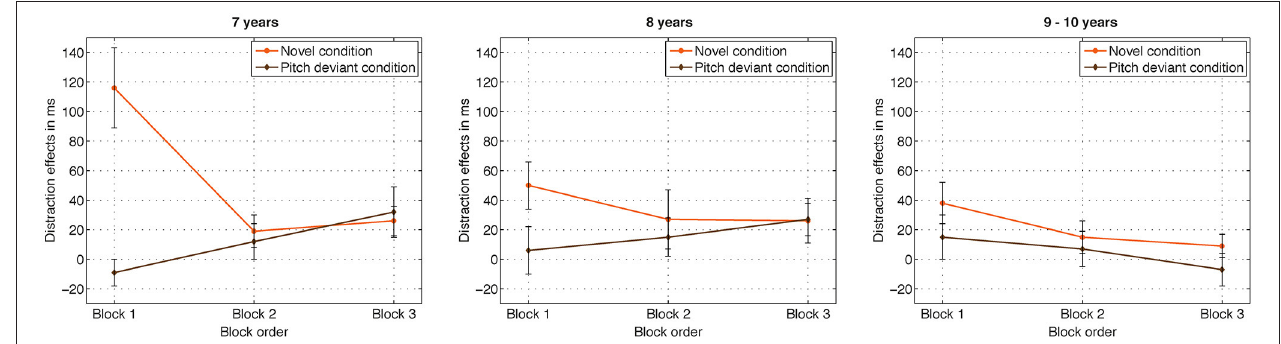
FIGURE 3 | Highlights the different course of distraction effects (distractor RT minus standard RT) throughout the session in the different age groups. Distraction effects significantly decreased from the first to the second block in the novel condition but not in the pitch-deviant condition in the 7-year-old children. A similar but less pronounced pattern was observed in the 8-year-old children but not in the 9–10-year-old